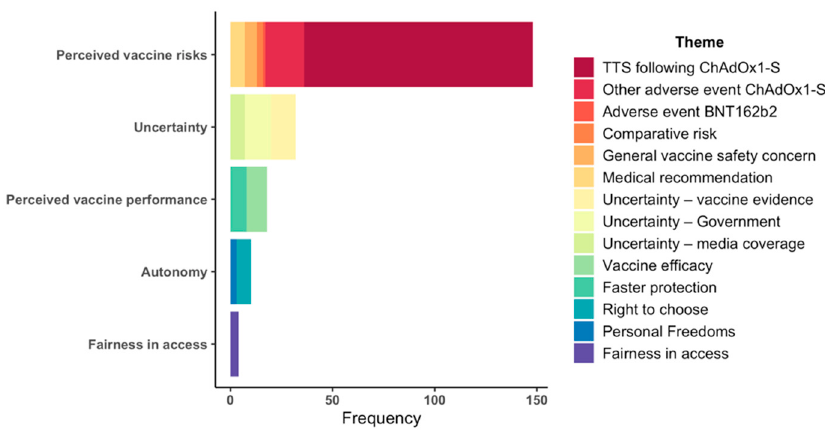
Figure 2. Frequency of concerns raised related to COVID-19